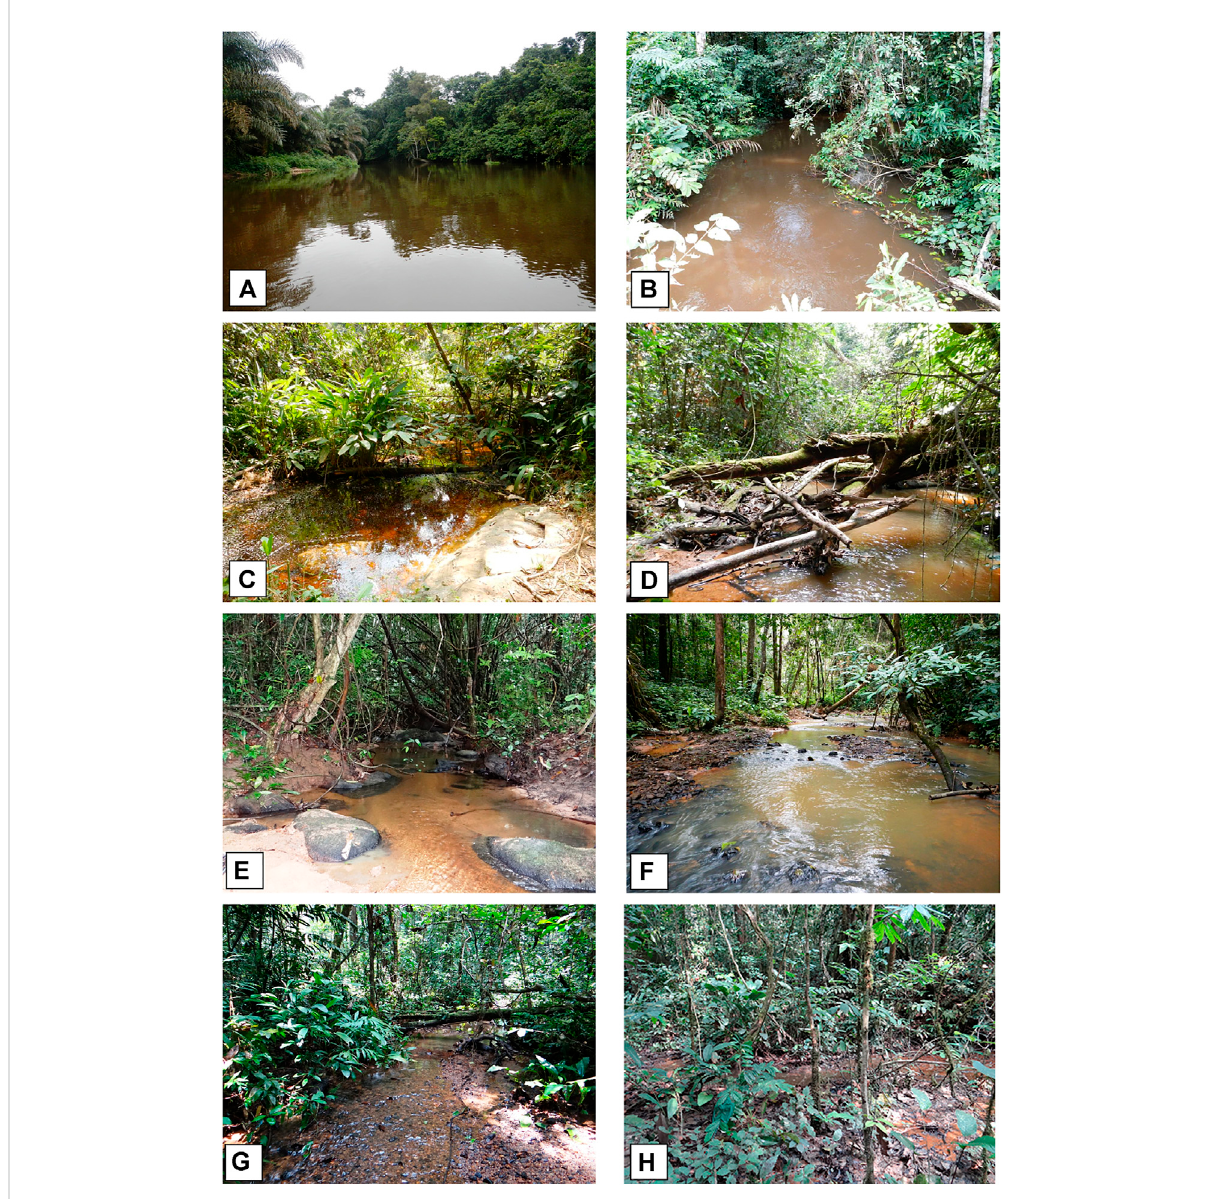
(Figure 1). The headwaters of the Kouilou-Niari River system originate in the upper basin (Figure 1) and are situated on the Chaillu Massif which consists of incised formations with steep-sloped hills and mountains covered by rare forest types (Mamonekene and Stiassny, 2012; van Rooyen et al., 2019). The upper basin freshwater habitat comprises forest streams on steep slopes, and rivers with varying degrees of forest cover on moderately steep slopes. (Figure 2A – H).